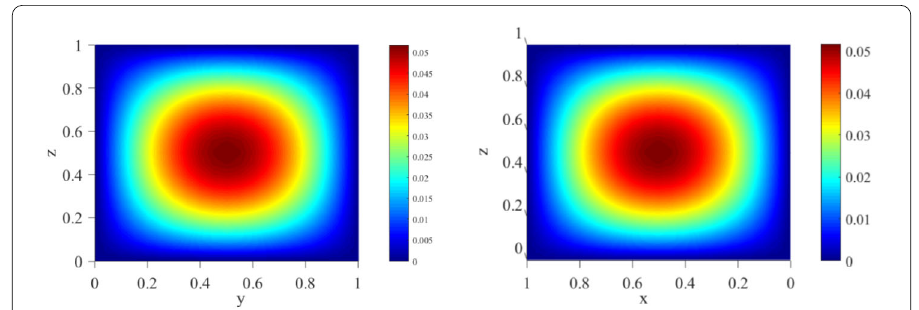
Figure 20 The slices of the four-dimensional figures of the solution of the three-dimensional problem for x = 0.5 (on left-hand side figure) and y = 0.5 (on right-hand side figure) for Example 6